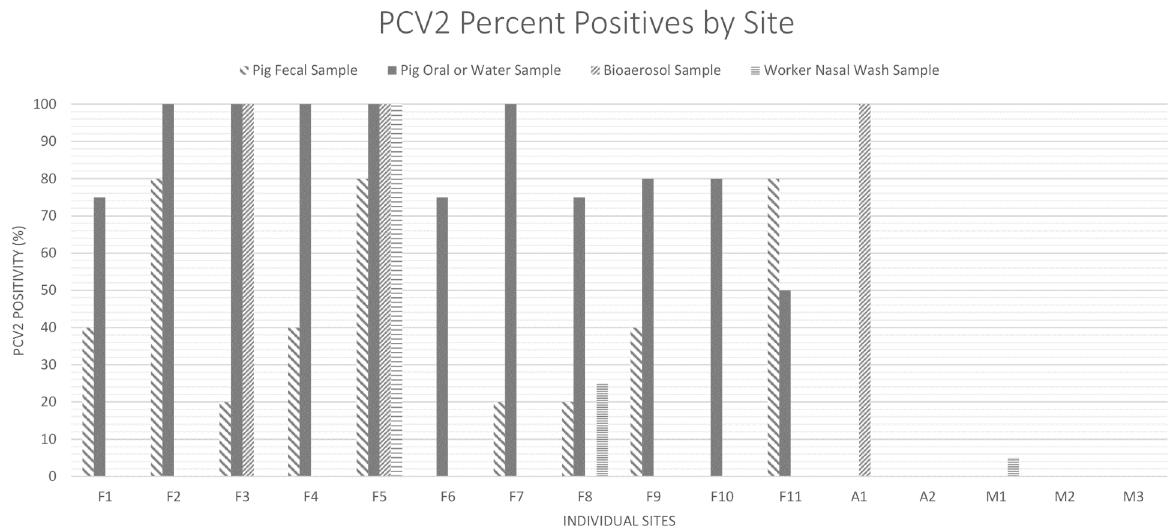
Fig 1. Molecular positivity for PCV2 detected via rPCR in samples collected from 11 farms, 2 abattoirs, and 3 live animal markets in Sarawak, Malaysia in June and July of 2017. Sites beginning with ‘F’ denotes farm, ‘A’ denotes abattoir, and ‘M’ denotes market; porcine circovirus 2